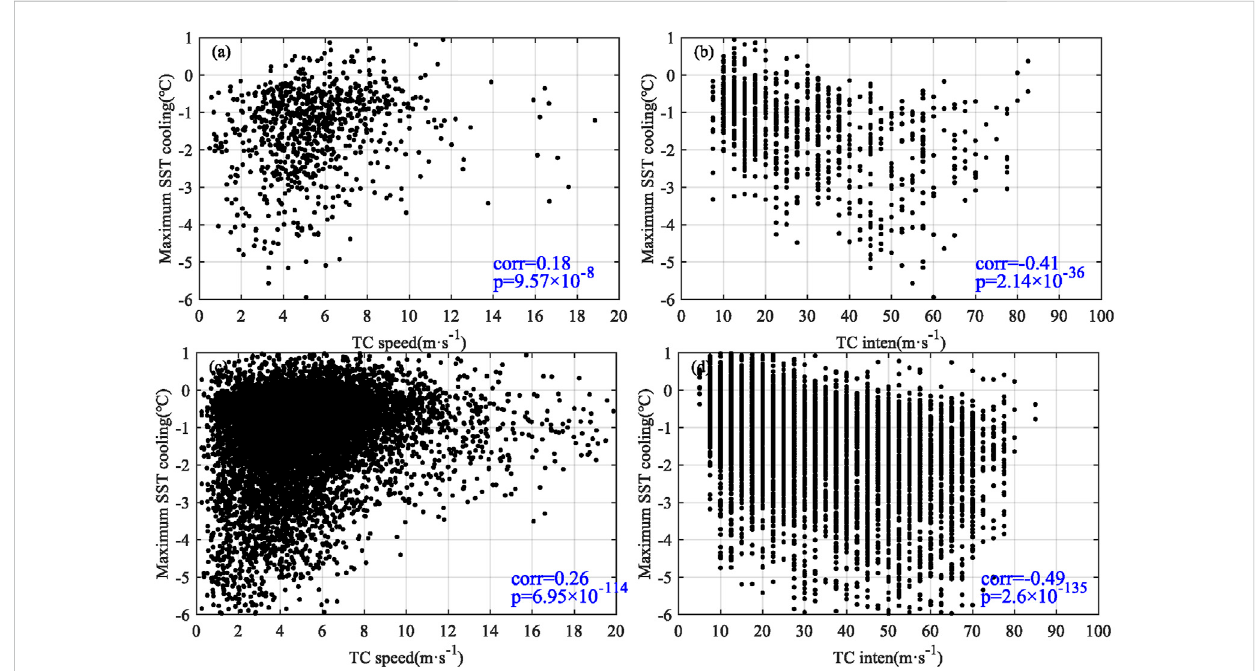
FIGURE 4 Scatterplots of the maximum SST cooling and the (A) speed and (B) intensity of the LTC at each 6-h location. Scatterplots of the maximum SST cooling and the (C) speed and (D) intensity of the single TC at each 6-h location. Numbers in each plot indicate the correlation coef fi cients and p-vaule. These correlation coef fi cients are statistically signi fi cant ( p <